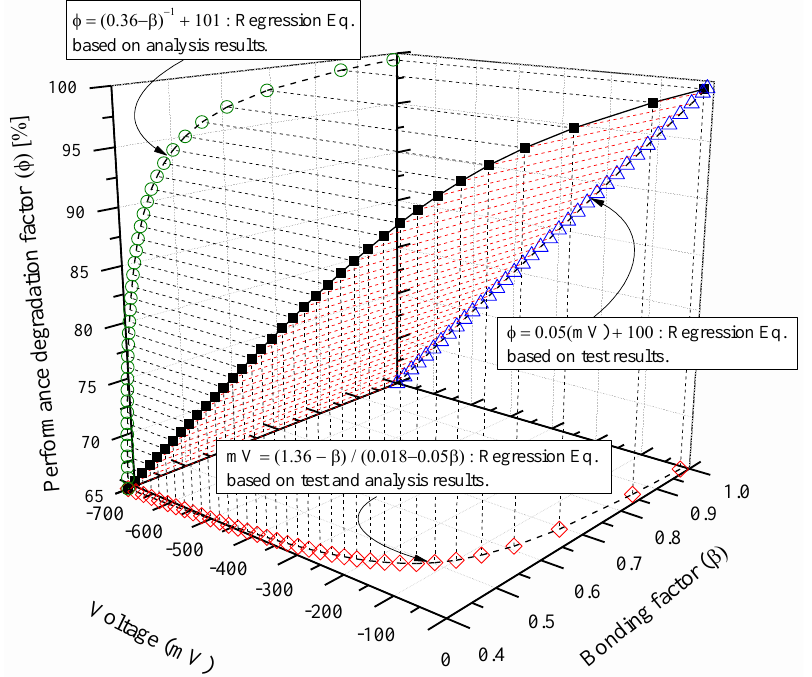
Figure 21. 3D plot of performance reduction factor ( ϕ ), bonding factor ( β ), and average potential difference in terms of voltage (mV) of corroded flexural beam.